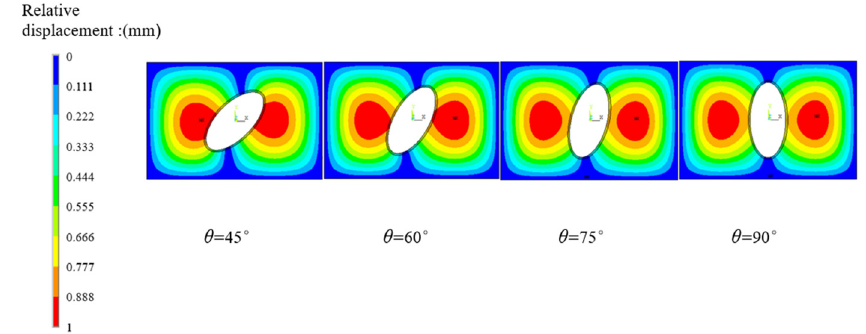
Figure 15: First - order buckling mode of the perforated plates with t = 8